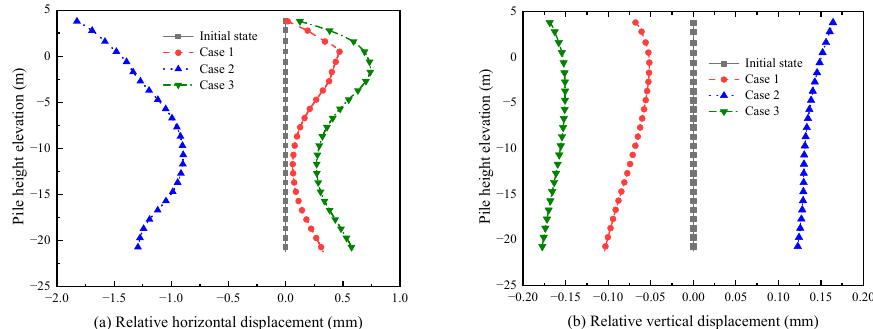
Figure 7. Horizontal and vertical displacement of No. 1 pile relative to No. 21 pile.